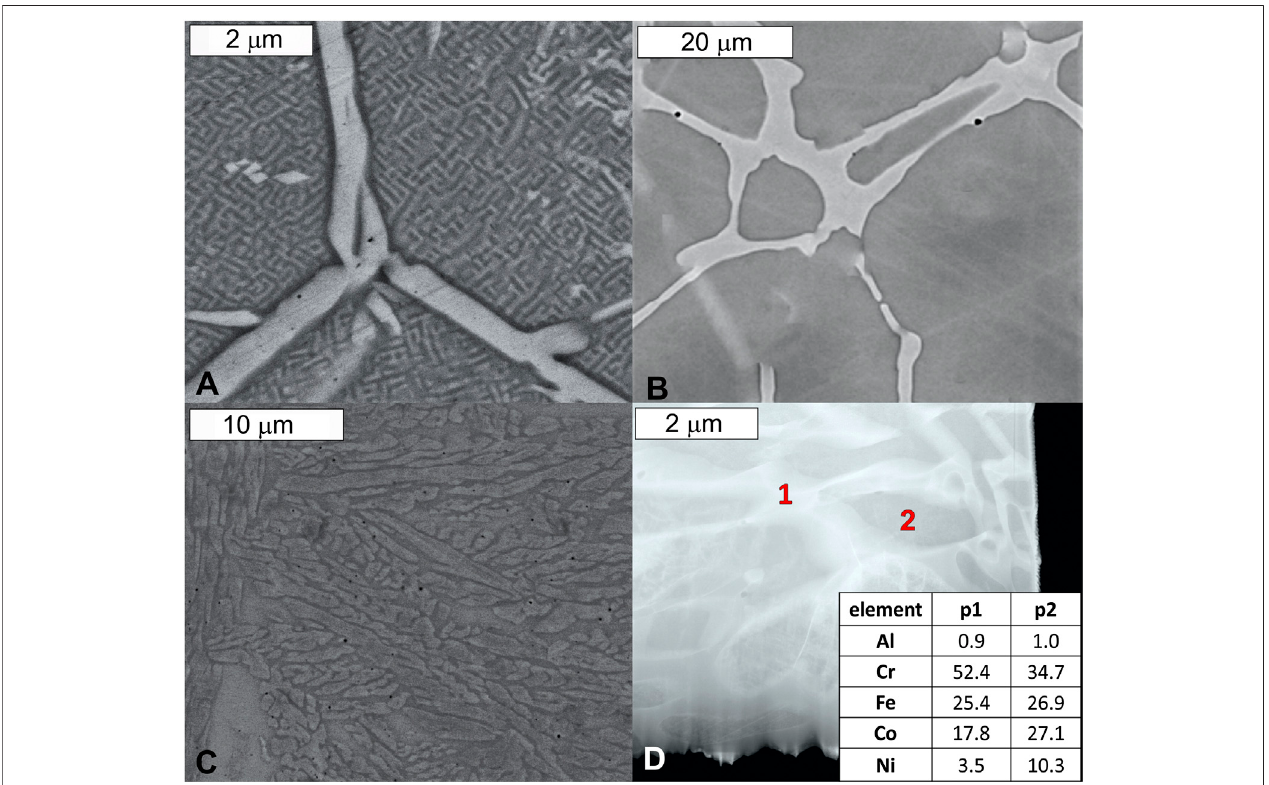
FIGURE3| MicrostructuresofAlCoCrFeNi (A) andtwoquinaryalloyswithcompositionsclosetoitsmajorcomponentBCC (B) andFCC (C , D) ;SEM (A – C) ,STEM (D) , EDS analysis (at.%) in marked points.